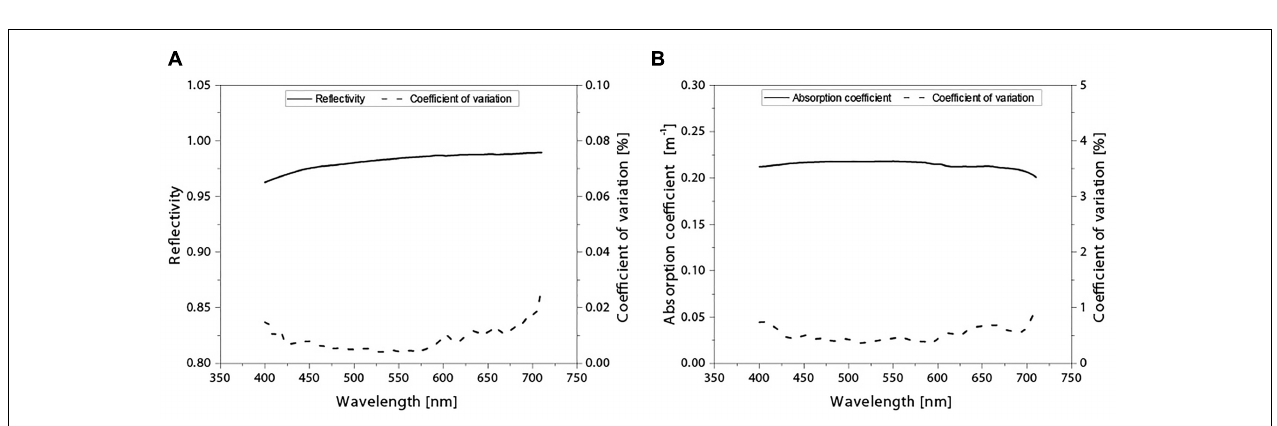
FIGURE 5 | Initial calibration of the PSICAM. (A) Mean reflectivity calculated from the calibration measurements using the nigrosine solution ( n = 4). (B) Mean absorption coefficient spectrum of the solid standard ( n = 5). The dotted line gives the coefficient of variation based on the standard deviation of the replicate